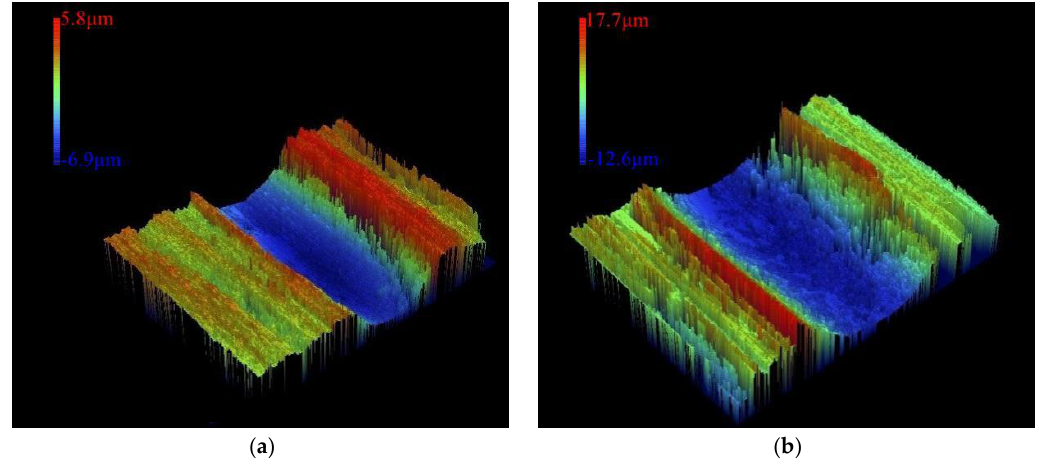
Figure 16. ( a ) Wear on the cladding layer. ( b ) Wear on the substrate.